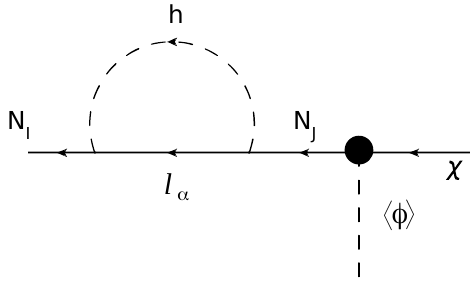
Figure 1 . The diagram contributing to the function f ( hl ) .